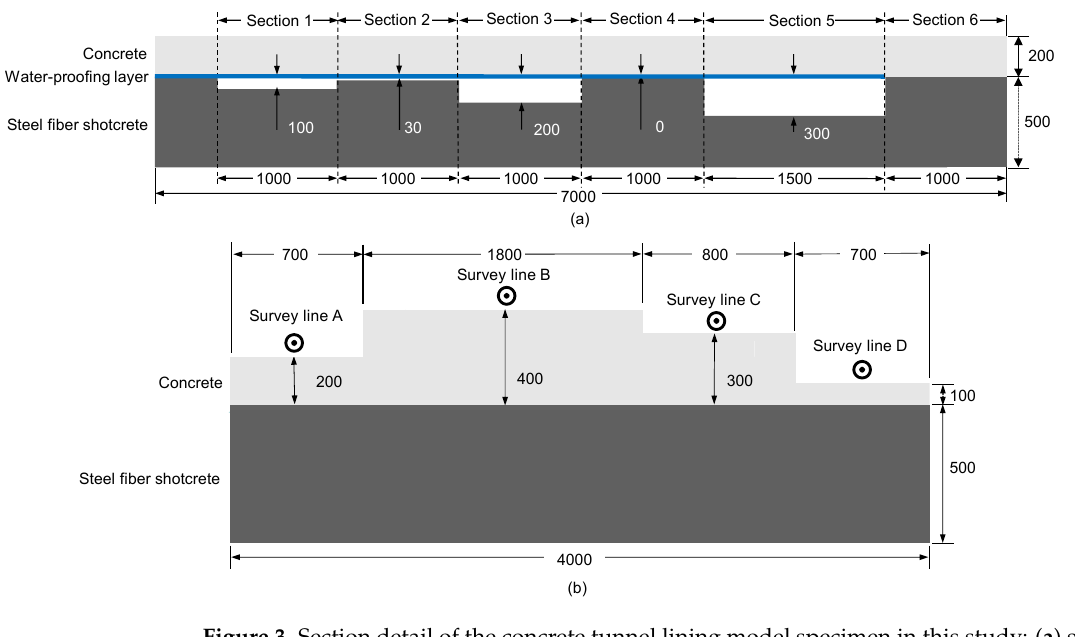
Figure 3. Section detail of the concrete tunnel lining model specimen in this study: ( a ) section A-A and ( b ) section B-B in Figure 2 (see also Figure 4 for survey lines for GPR survey in this study).